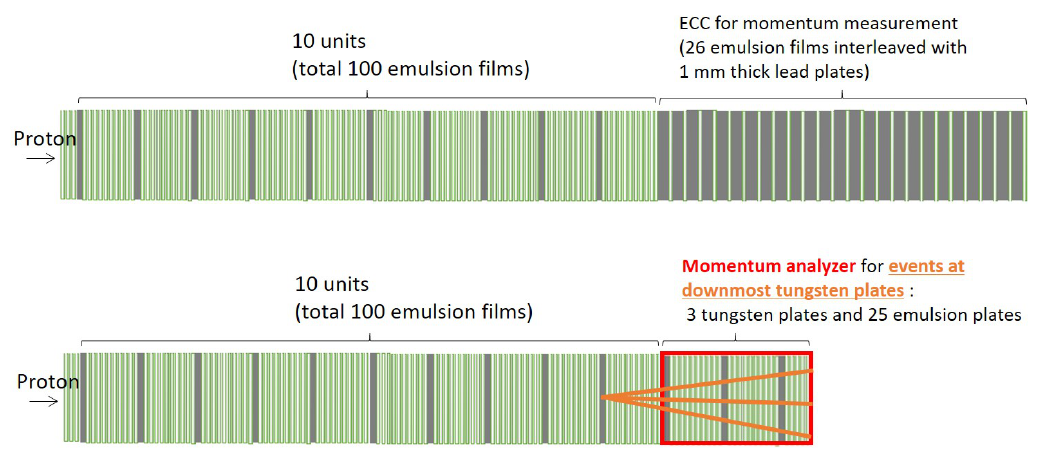
Figure 1: Schematic view of emulsion